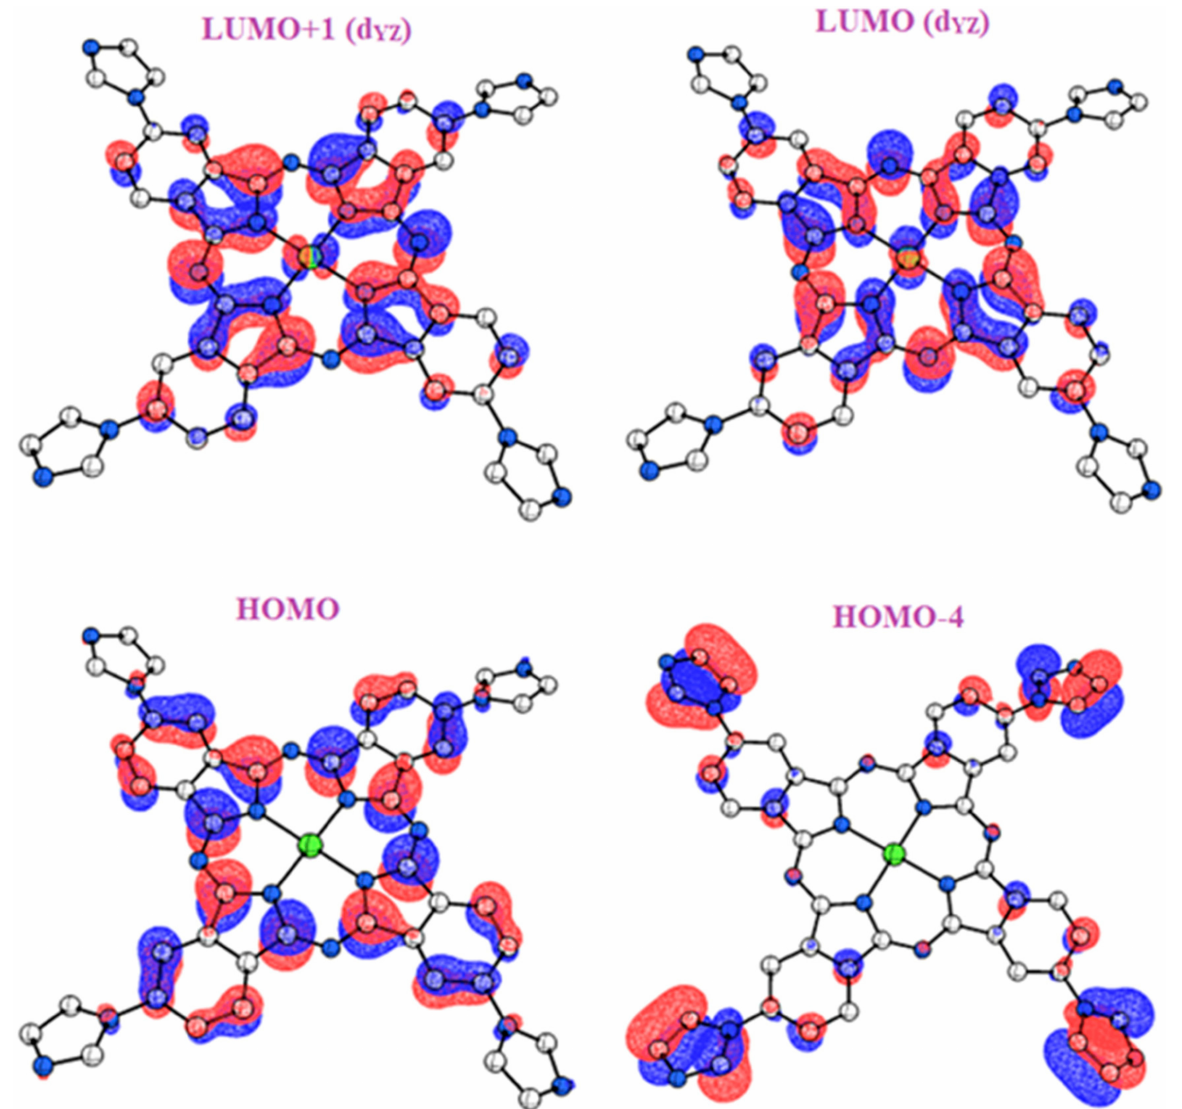
Figure 2. OMs that contribute to UV transitions. Contour plots (contour value = 0.025) of HOMO-n and LUMO + n of PdPc(Im) 4 calculated at the B3LYP-D3/SDD level of theory in DMSO. LUMO and LUMO + 1 are